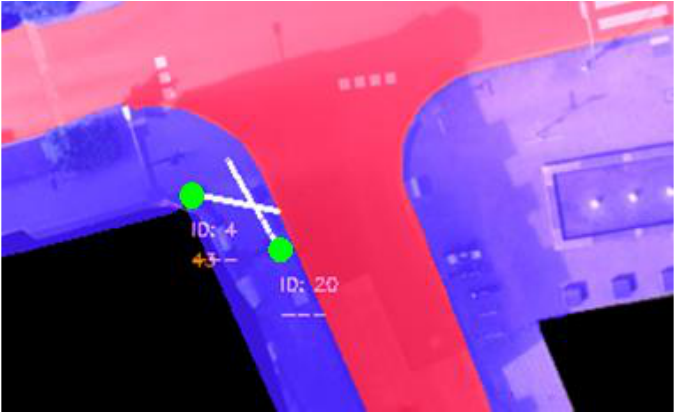
Figure 2. Distance to the road from current pedestrian position. The pedestrian current position is represented by the point shown in green and the heading direction by the white line.